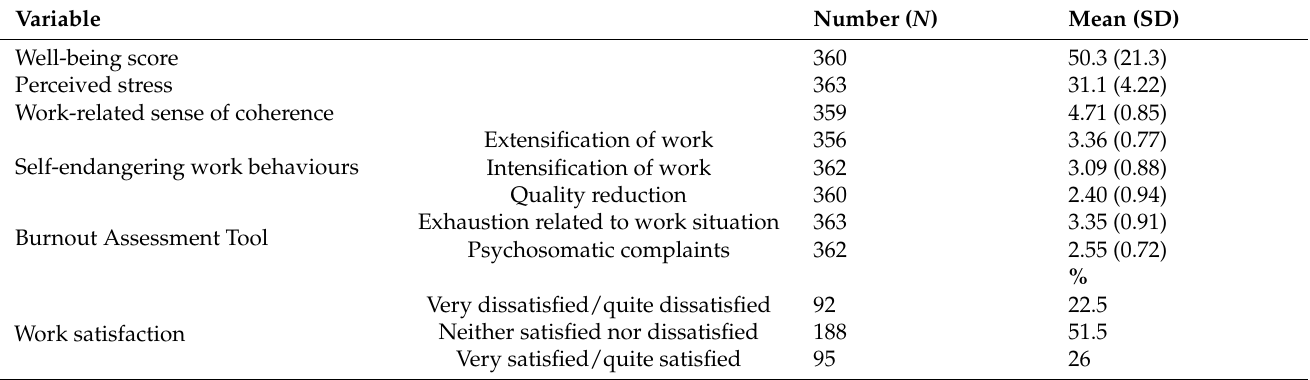
Table 2. Descriptive statistics of participants’ well-being, stress and stress-related behaviours ( N =